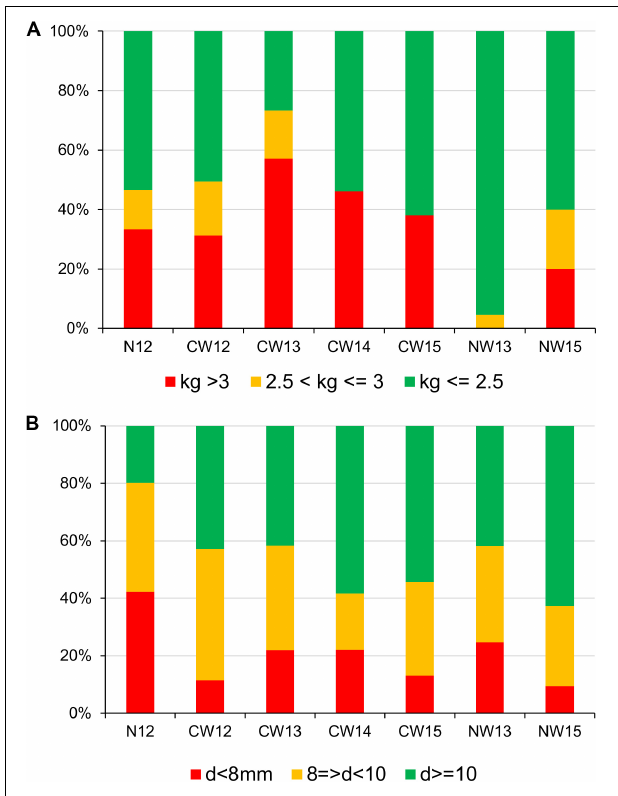
FIGURE 6 | Percentage of dives performed within (green) or outside (red) the legal limits in terms of weight per dive (A) . Percentage of colonies collected within (green) or outside (red) the legal limits in terms of size (B) in the different areas (N, northern coast, CW, central–western coast, NW, northwestern coast of Sardinia) and years. In orange, the values obtained considering a tolerance of 20% on the fixed limits to allow for errors.